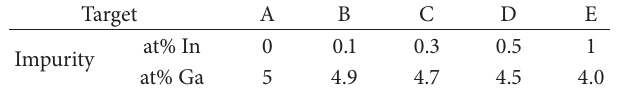
Table 1: The ZnO targets with various percentages of Ga and In atoms. Target A B C D E at% In 0 0.1 0.3 0.5 1 Impurity at% Ga 5 4.9 4.7 4.5